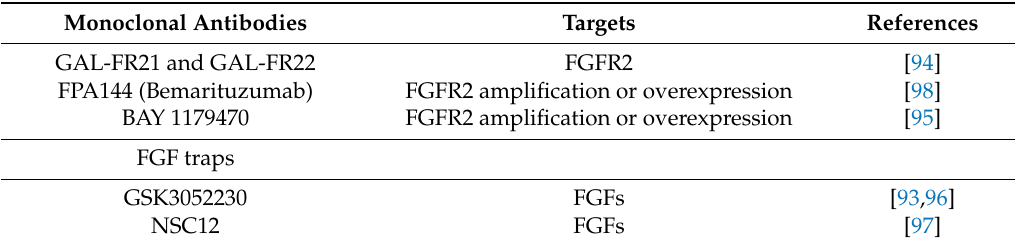
Table 1. A list of anti-FGFR monoclonal antibodies and FGF traps potentially employed in GC. Monoclonal